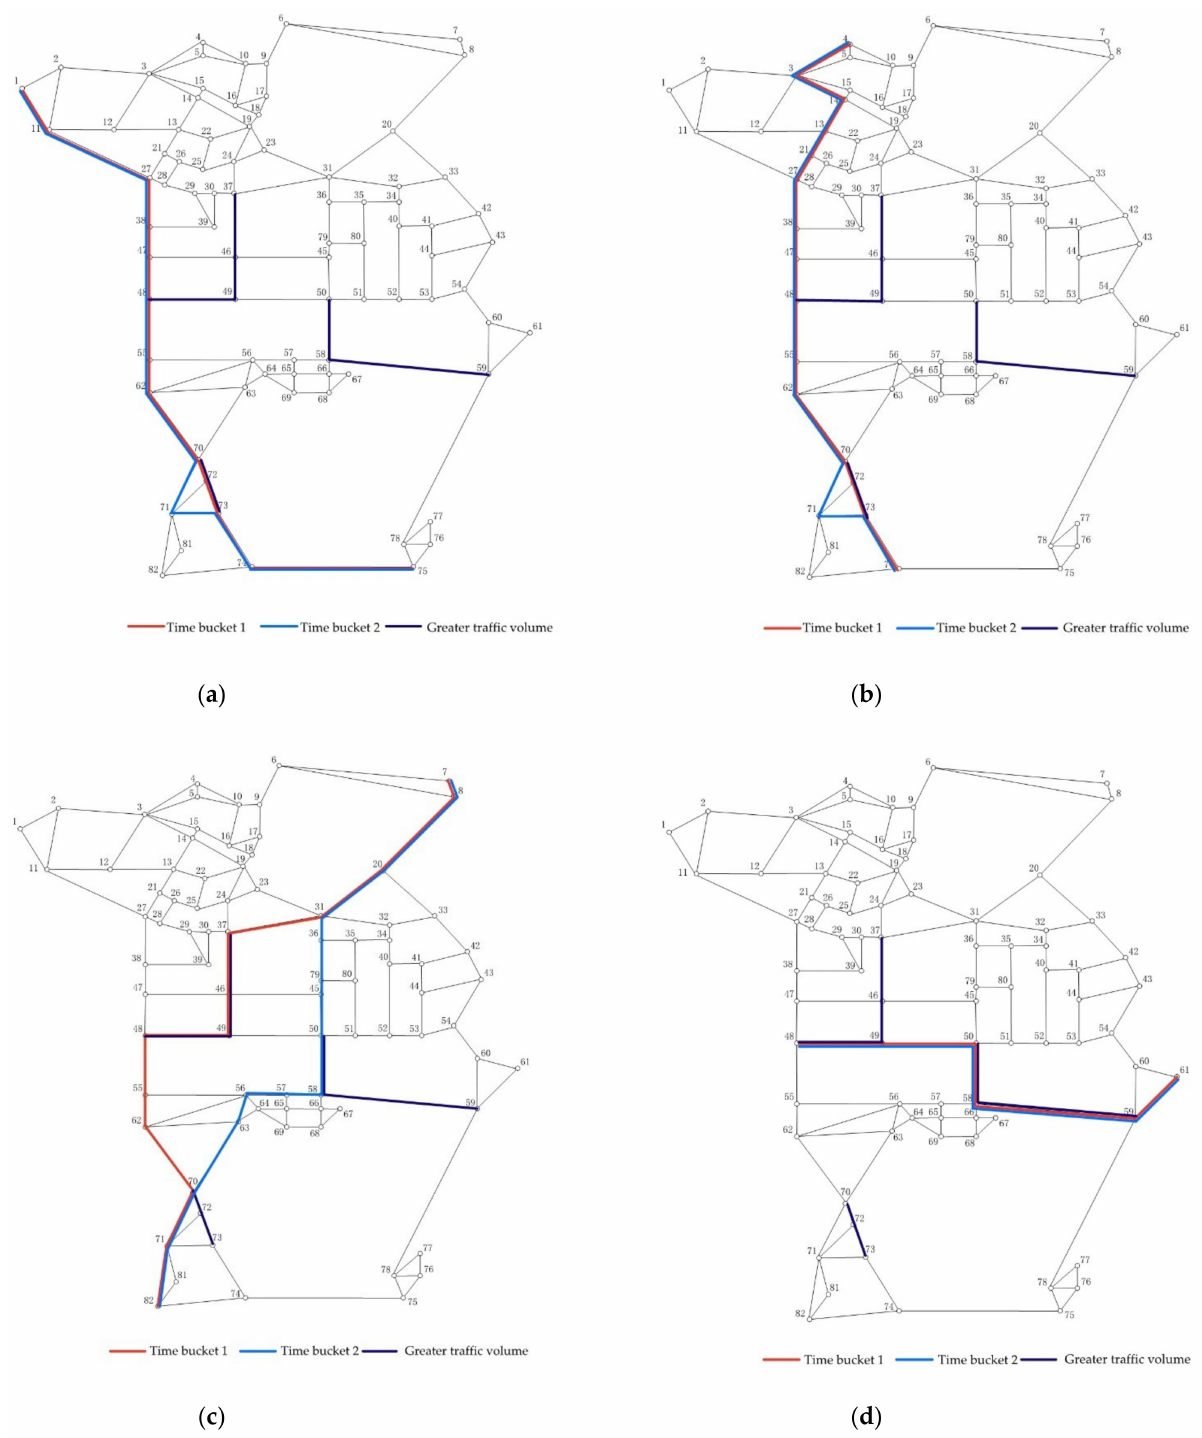
Figure A2. Under different traffic volume, ( a ) The route from points 1 to 75. ( b ) The route from points 4 to 74. ( c ) The route from points 7 to 82. ( d ) The route from points 48 to